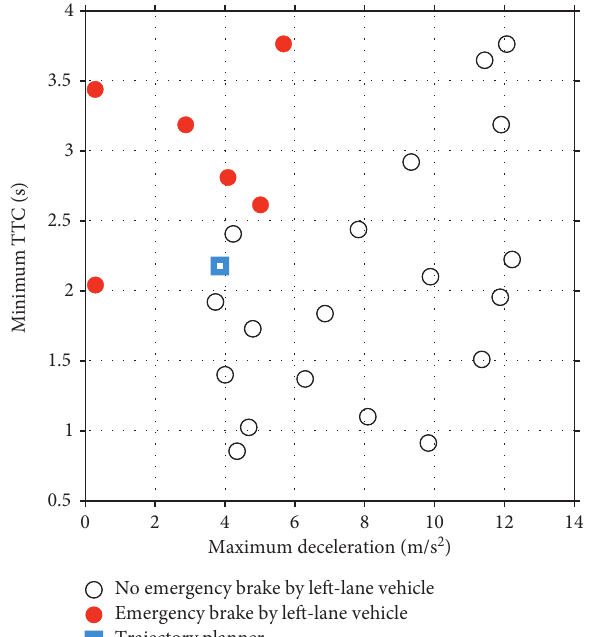
Figure 9: Scatter plot showing each participant’s minimum TTC (MTTC) and maximum longitudinal deceleration in Scenario 3 (time budget � 7s and traffic density � medium). A distinction is made between trials in which the approaching vehicle in the left lane made an emergency brake (in red) or not (in wide). Also shown are the trajectory planner values.